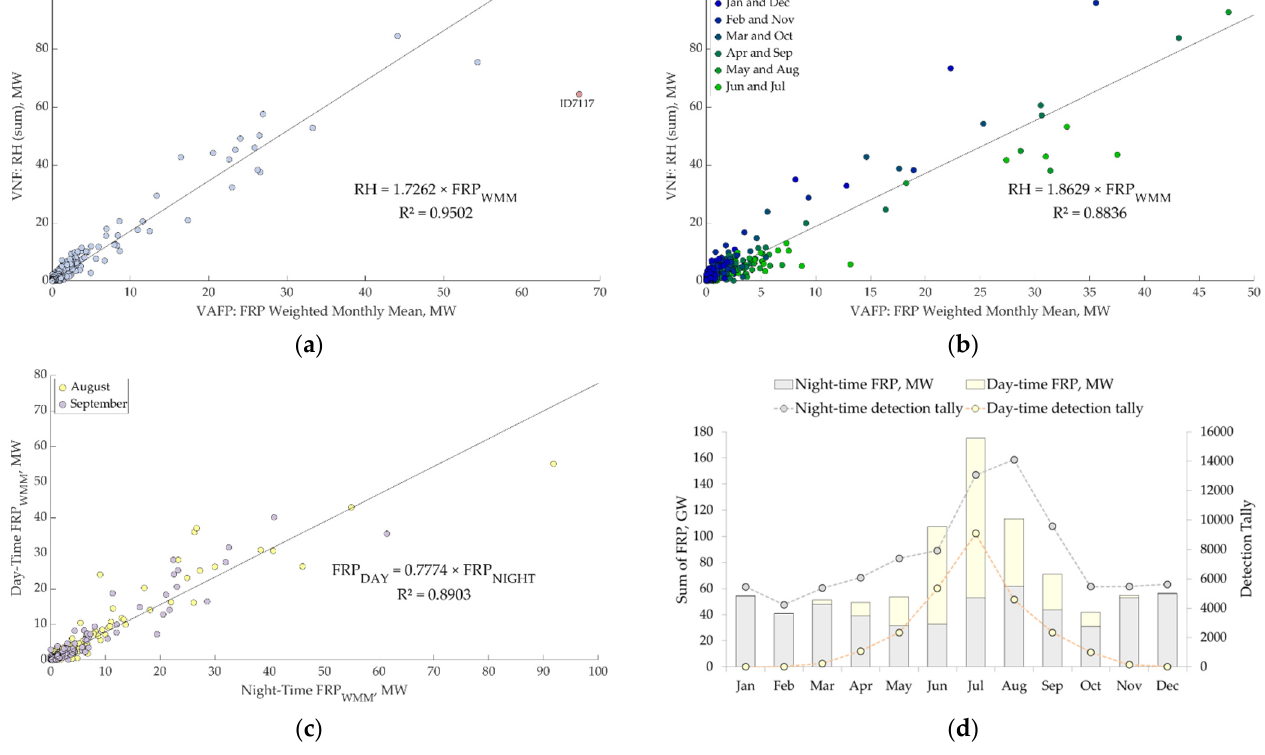
Figure 14. Preliminary analysis of VIIRS Active Fire Product (VAFP) [63] Fire Radiative Power ( FRP ) estimates for the hotspots detected within VIIRS Nightfire gas flare contours located in Russia in 2019. ( a ) Plot of VAFP annual weighted monthly mean FRP ( FRP WMM ; in MW) vs. VIIRS Nightfire annual Radiant Heat ( RH ; in MW) (N.b. RH from Equation (2) is used instead of RH’ from Equation (4).) Note that the point ID7117 is considered an outlier and is thus excluded from the resulting correlation. ( b ) Plot VAFP monthly FRP WMM (MW) vs. VIIRS Nightfire monthly RH (MW) for gas flares that remain confidently detectable with Nightfire in June (roughly latitudes < 55° N). ( c ) Plot night-time vs. daytime monthly VAFP FRP WMM (MW) in August and September. ( d ) Histogram monthly day and night-time distribution of raw (non- weighted) FRP (in GW) and graph VAFP detection tally within VIIRS Nightfire gas flare contours. Initially, a strong correlation (R 2 = 0.91) is observed; however, a single point, ID 7117 (67.81° N 72.53° E), appears to be a conspicuous outlier. It corresponds to a large four